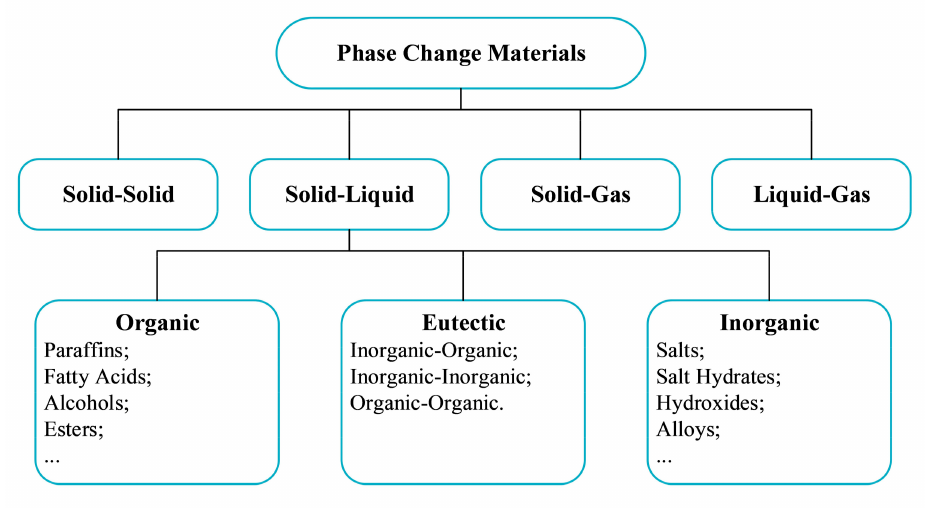
Figure 1. Classification of